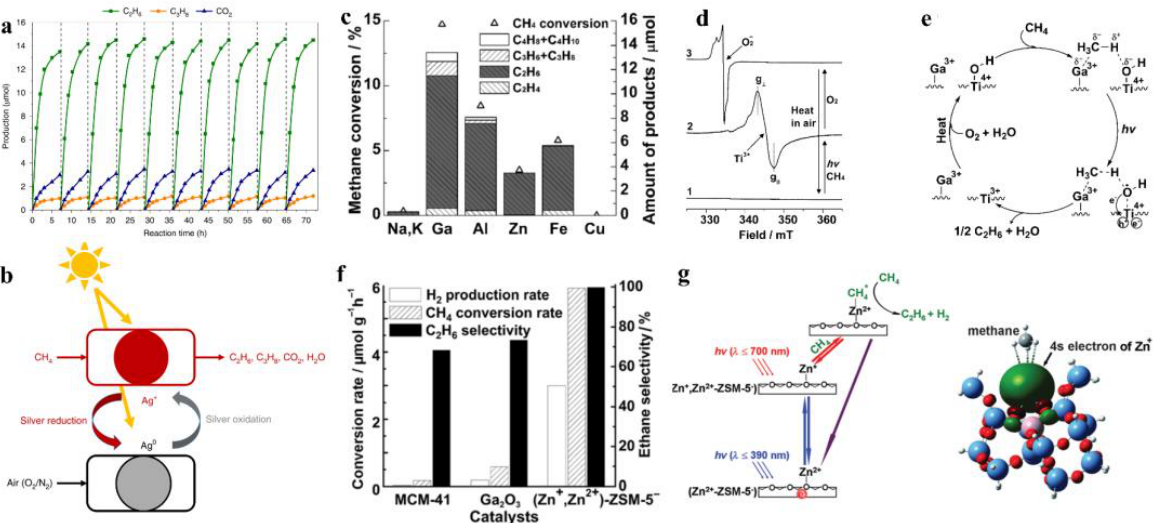
Figure 4. ( a , b ) Production and mechanism of Ag–HPW/TiO 2 catalyst in photocatalytic NOCM [2], copyright 2020, Springer Nature. ( c , d ) CH 4 conversion and product distribution were obtained in the photo-driven CH 4 activation reaction over various substrates under direct irradiation. From left to right: Na, K-ETS-10-0.2, Ga-ETS-10-0.2, Al-ETS-10-0.2, Zn-ETS-10-0.2, Fe-ETS-10-0.2, and Cu-ETS-10-0.2 [41], ( e ) EPR results of Ga-ETS-10-0.2 [41], copyright 2012, John Wiley and Sons. ( f ) CH 4 conversion and C 2 H 6 selectivity of Zn 2+ -ZSM-5 − catalyst [44], and ( g ) mechanism of Zn 2+ -ZSM-5 − catalyst in photocatalytic NOCM [44]. Copyright 2011, John Wiley and Sons.